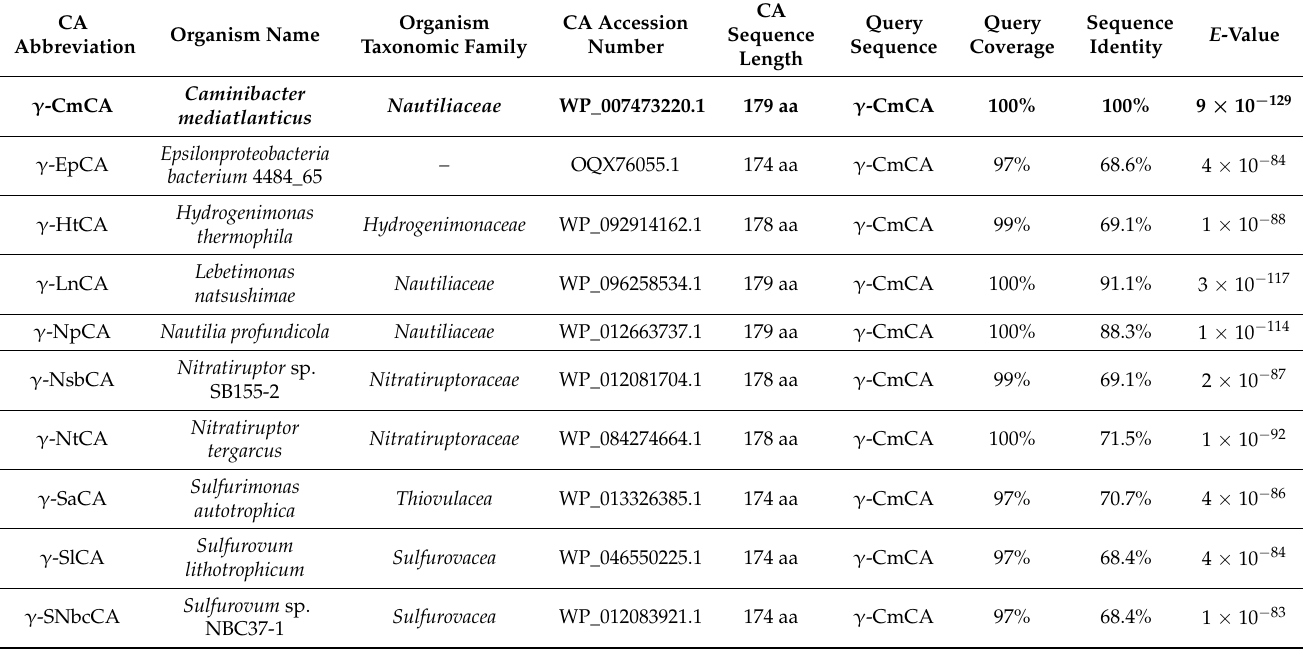
Table 1. List of γ -CA sequences retrieved from NCBI as well as their attributes. The query coverage, sequence identity, and E-value were obtained from NCBI BLAST, and the taxonomic families were obtained from NCBI Taxonomy. The query sequence is shown in